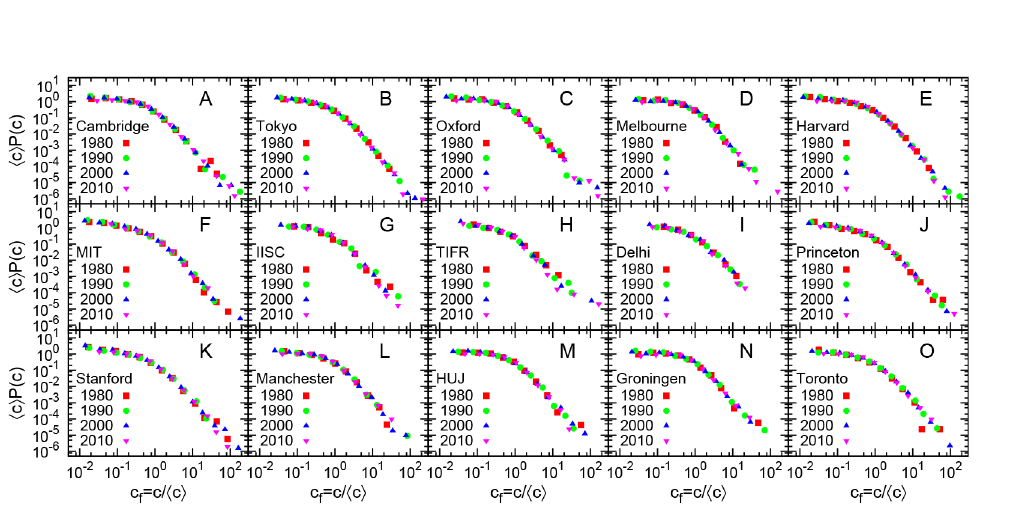
Fig 2. Rescaled probability distributions of citation for several academic institutions for different years. Probability distribution P (c) of citations c rescaled by average number of citations h c i to publications from 4 different years (1980, 1990, 2000, 2010) for several academic institutions. For any institution, the data for different years seem to follow the same